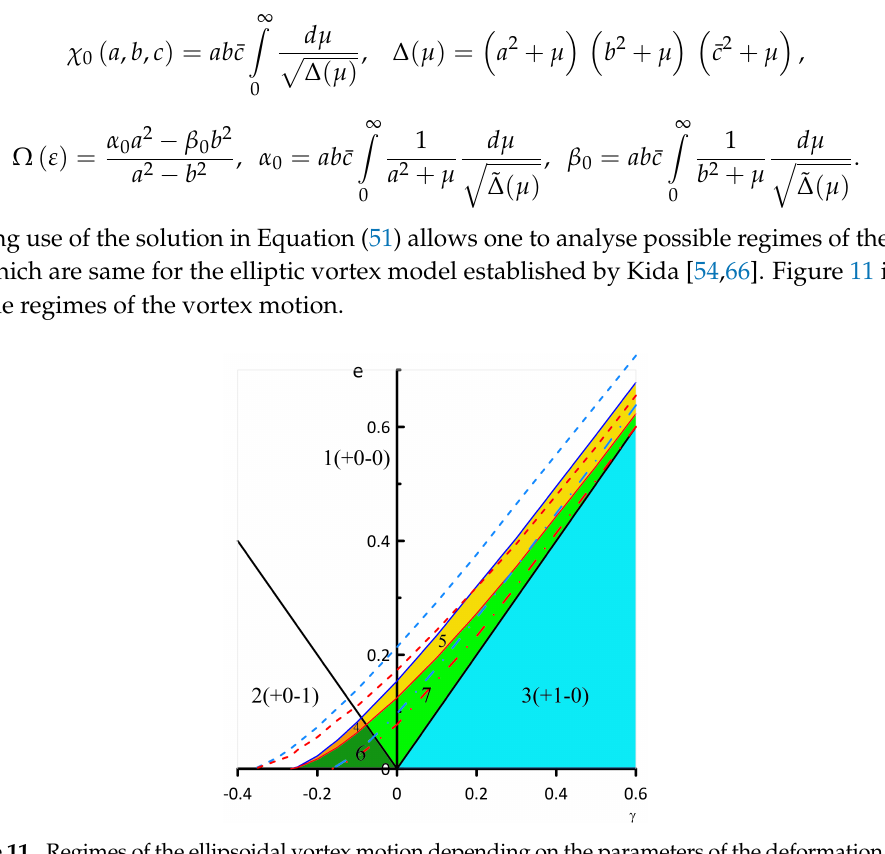
Figure 11. Regimes of the ellipsoidal vortex motion depending on the parameters of the deformation